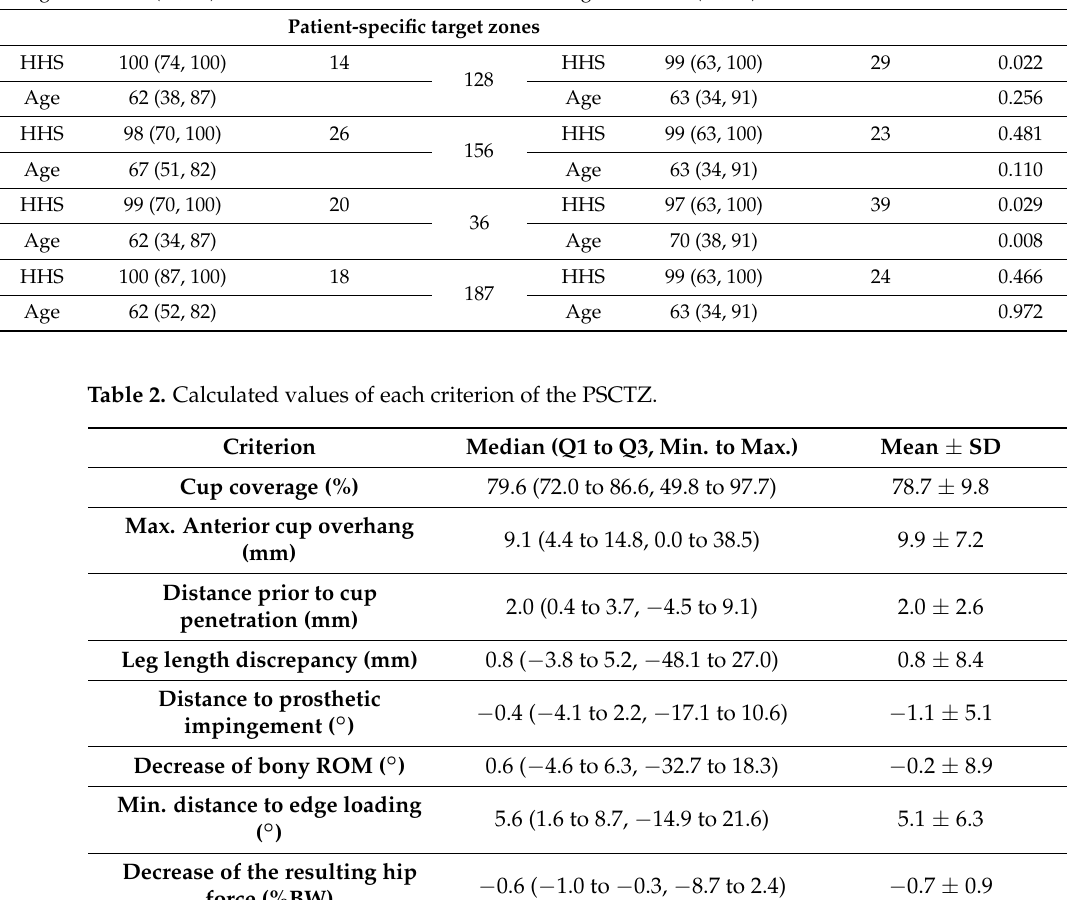
Dorr combined anteversion